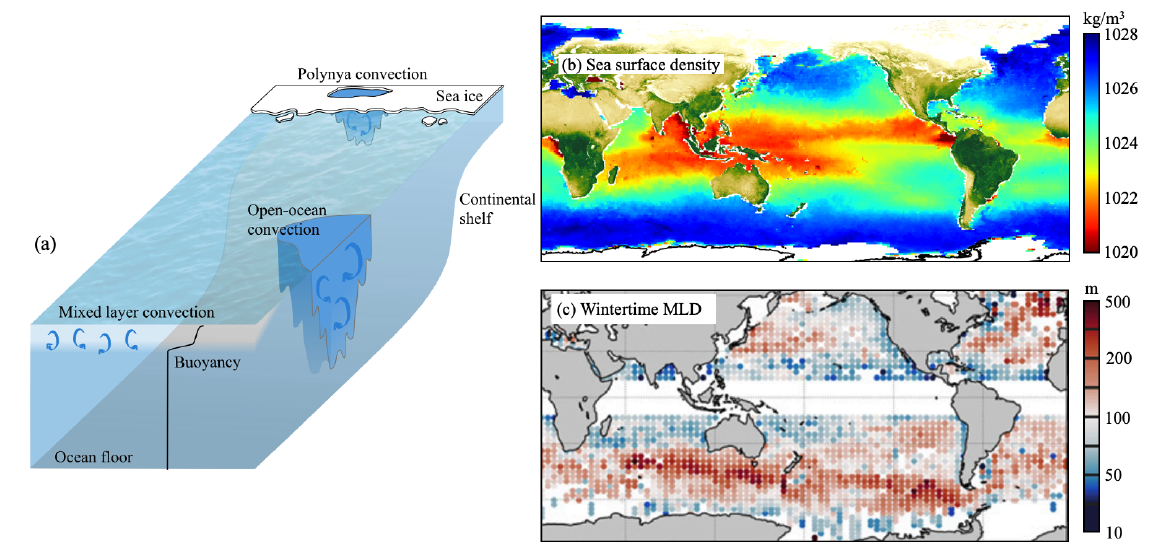
Figure 1. ( a ) Schematic of different types of ocean convection forced by surface buoyancy loss: mixed layer convection, open-ocean convection and polynya convection (shown for a coastal polynya). ( b ) Sea-surface density from monthly average March data (image generated using dataset from NASA Aquarius project [8]). ( c ) Wintertime mixed layer calculated from 2010–2019 Argo floats in February (Northern Hemisphere) and August (Southern Hemisphere) using the method outlined by Huang et al. [9], which excluded equatorial regions below 10 ◦ latitude [7]. Panel ( c ) is reproduced with permission from Dong et al. [7] ©American Meteorological